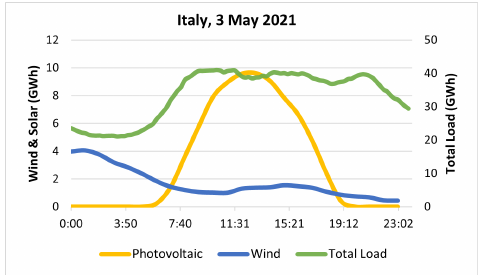
Figure 2. Typical daily Italian grid electricity demand, May 2021, TERNA S.p.A.